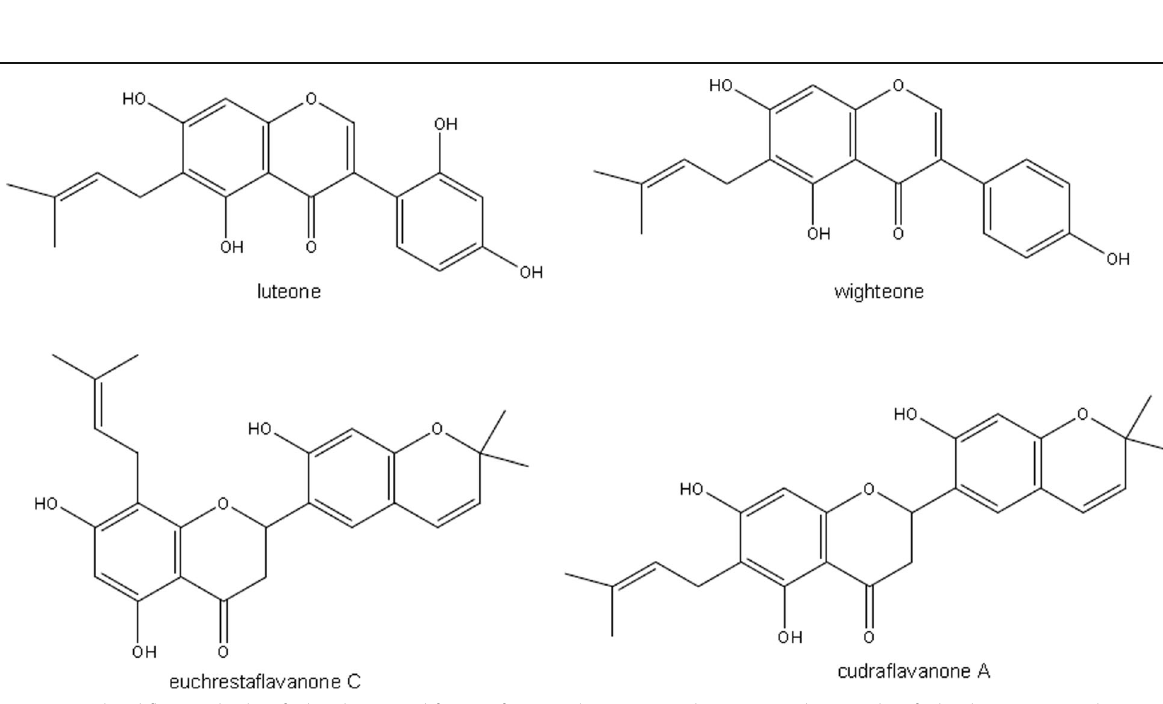
Fig. 3 Prenylated flavonoids identified in the 11FO d fraction from Maclura tinctoria. The compounds were identified as luteone (1), wightenone (2), euchrestaflavanone C (3), cudraflavanone A (4), and diprenylated